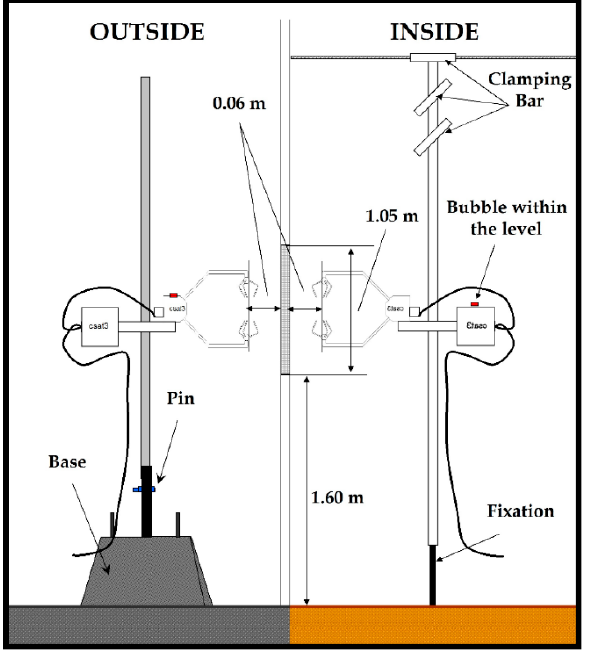
Figure 3. Sketch of the setup of the 3D anemometers placed at the side vent north.